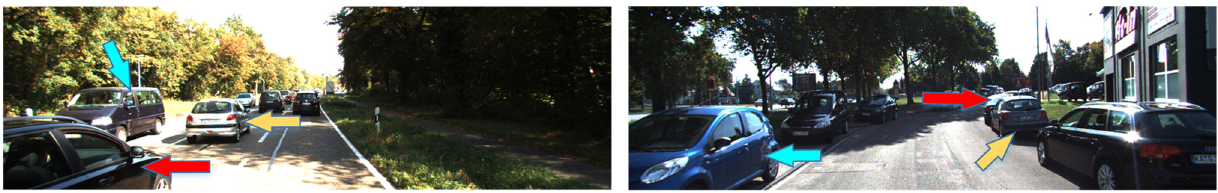
Table 1. Comparisons of and on KITTI val1/val2 sets.